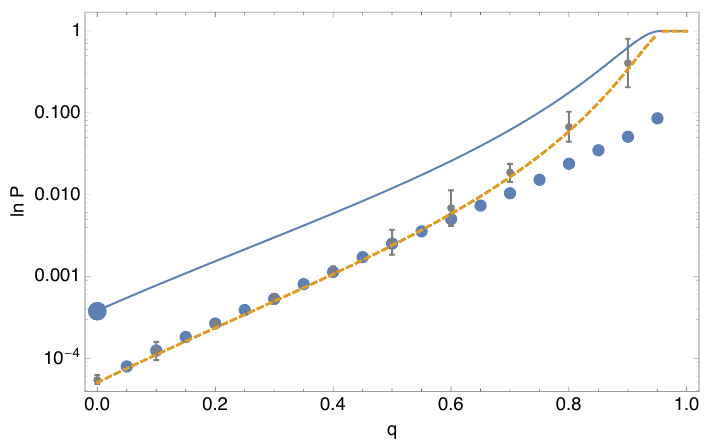
Figure 5 . Exit probability for the orthogonal ensemble ( (cid:12) = 1) with N = 5. Small circles denote the (cid:13)uctuation probability estimated by performing a matrix random walk with 10 6 matrices, the grey points with error bars correspond to numerical integration of the pdf, the blue/continuous line denotes the leading N 2 approximation, the yellow/dashed line includes the subleading corrections to the Hamiltonian. The large blue circle at q = 0 represents the Dean and Majumdar’s result for the static